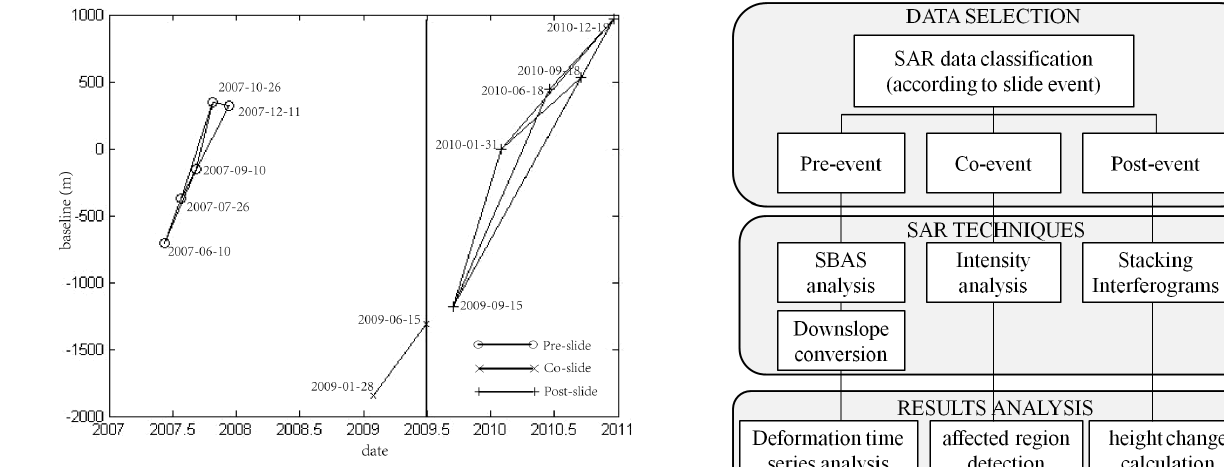
Fig. 2. Schematic figure on SAR combinations of ALOS/PALSAR imagery data for the Jiweishan rockslide analysis, different symbols indicate different SAR combinations.